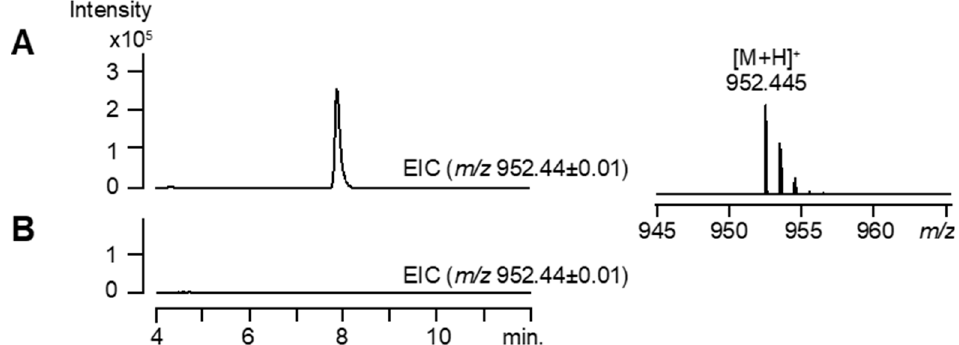
Figure 3. Heterologous expression of the MeACC cluster in S. lividans TK23. ( A ) The MeACC cluster was cloned (pKU518_MeACC) and introduced into a heterologous host strain, S. lividans TK23. The resulting transformant, TK23_MeACC, was cultured and analyzed by high-performance liquid chromatography and high-resolution electrospray ionization mass spectrometry (HPLC-HR-ESI-MS). The extracted ion chromatogram (EIC) for m / z 952.44 ± 0.01 is shown. ( B ) The TK23 strain harboring the pKU518 empty vector (TK23_empty) was cultured and analyzed by HPLC-HR-ESI-MS. The EIC for m / z 952.44 ± 0.01 is